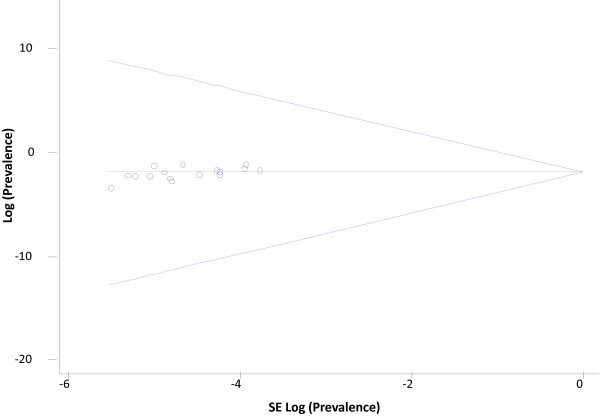
Publication bias: funnel plot.